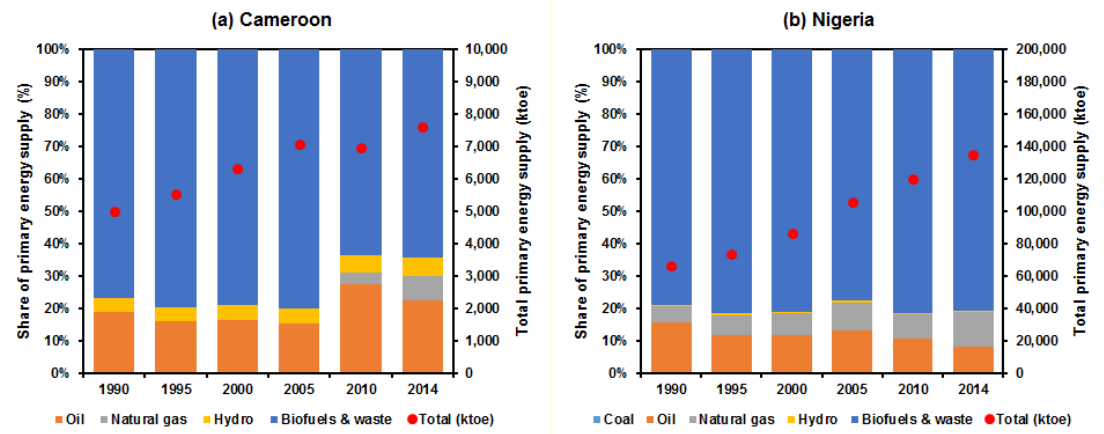
Figure 3. Total primary energy supply (in ktoe) for ( a ) Cameroon and ( b ) Nigeria in 2014. Adapted from